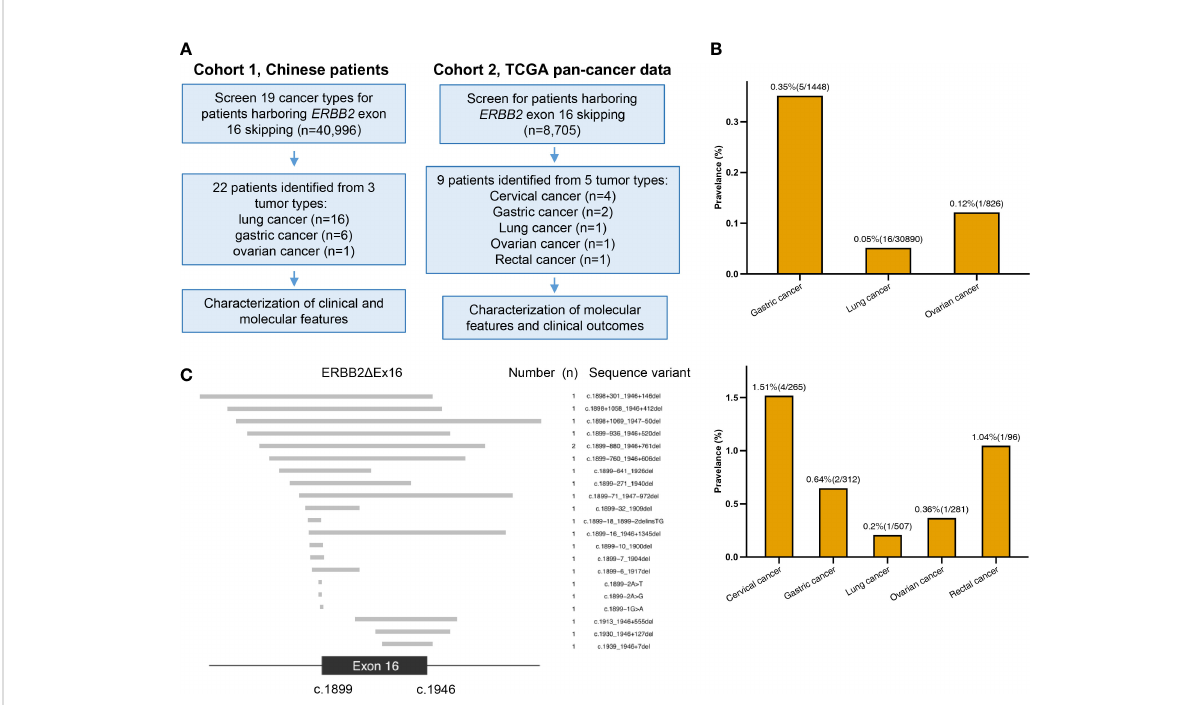
FIGURE 1 Study design and somatic ERBB2 exon 16 skipping ( ERBB2 D Ex16) analyzed in this study. (A) A diagram of study work fl ow. (B) Number of ERBB2 D Ex16+ patients from Cohorts 1 (upper panel) and 2 (lower panel) per tumor type, shown above the bars are the tumor type-speci fi c prevalence (number of ERBB2 D Ex16+ patients/number of screened patients). (C) Diagram of the 22 unique sequence variants detected in the Chinese cancer patients cohort. The exon 16 (between nucleotides 1899 to 1946) and the fl anking regions are shown, in which the gray bars correspond to each unique ERBB2 D Ex16 isoform as shown by the sequence variant on the right